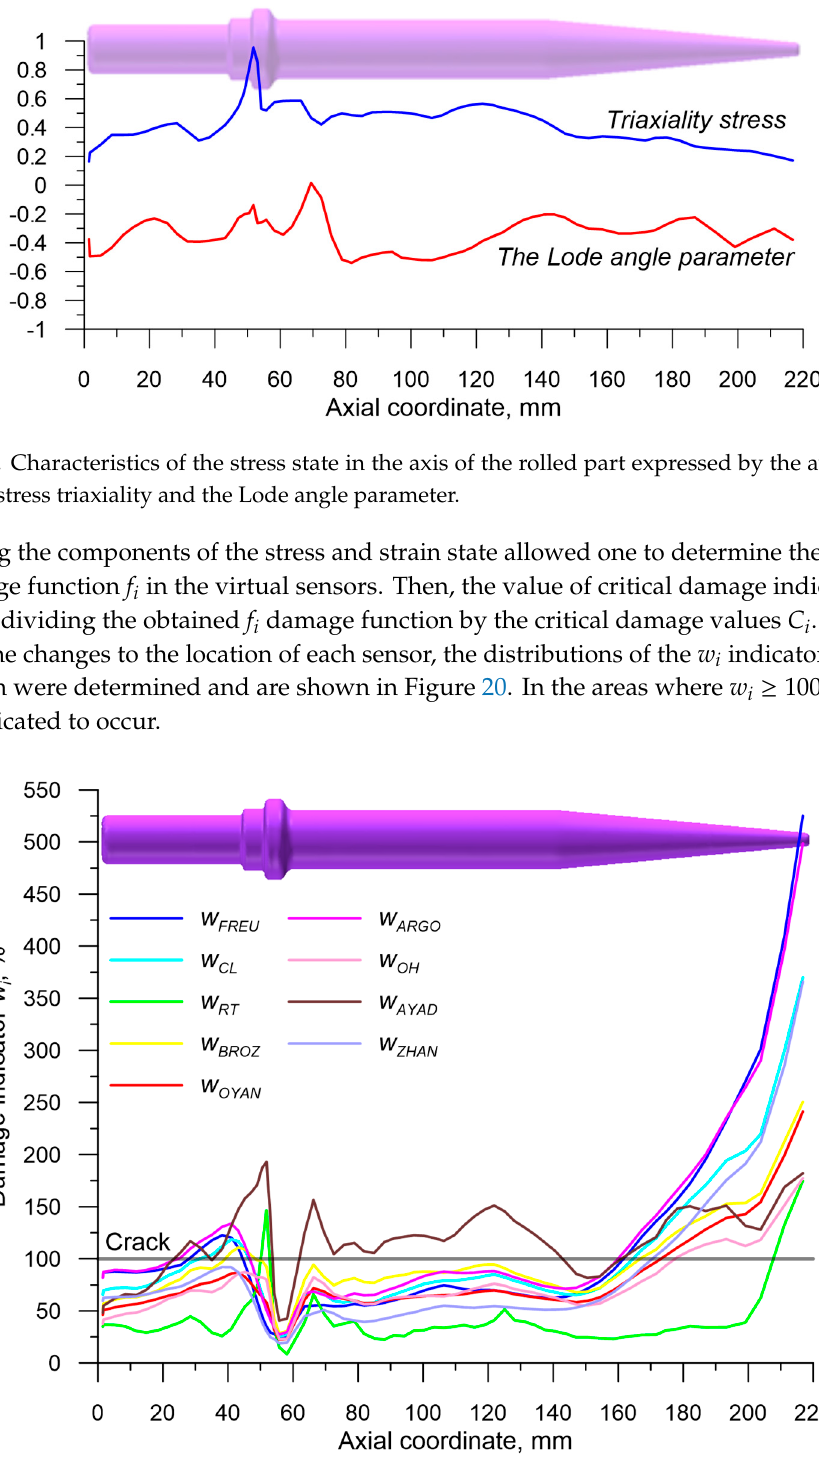
Figure 20. Distributions of the damage function in the axis of the analyzed preform, manufactured by the CWR method. the CWR